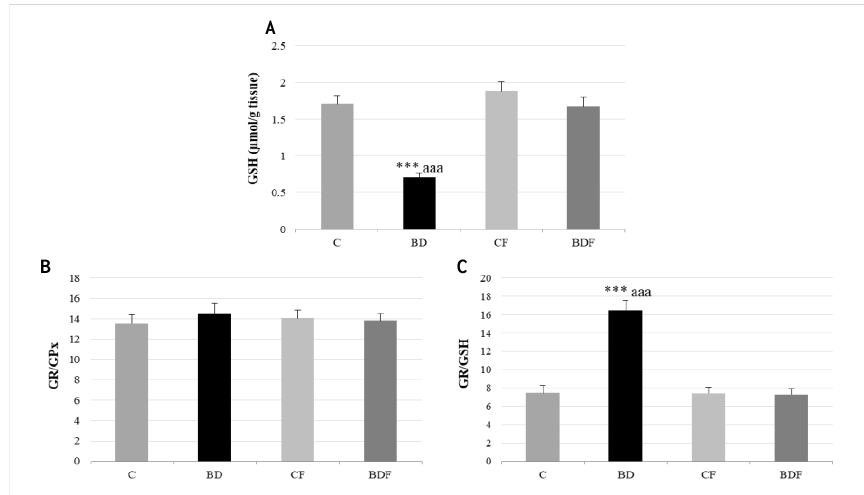
Figure 3. Hepatic GSH levels and their relationship to GPx and GR enzymes. GSH ( A ), GR/GPx ratio ( B ) and GR/GSH ratio ( C ) in the liver. The results are expressed as mean ± SEM and analysed by a multifactorial one-way ANOVA followed by Tukey’s test. The number of animals in each group is 6 and n = 12. SEM: standard error of the mean. Groups: C: control group, BD: binge drinking group, CF: control folic group, BDF: binge drinking folic group. Signification: C vs. BD: *** BDF: aaa p < 0.001.